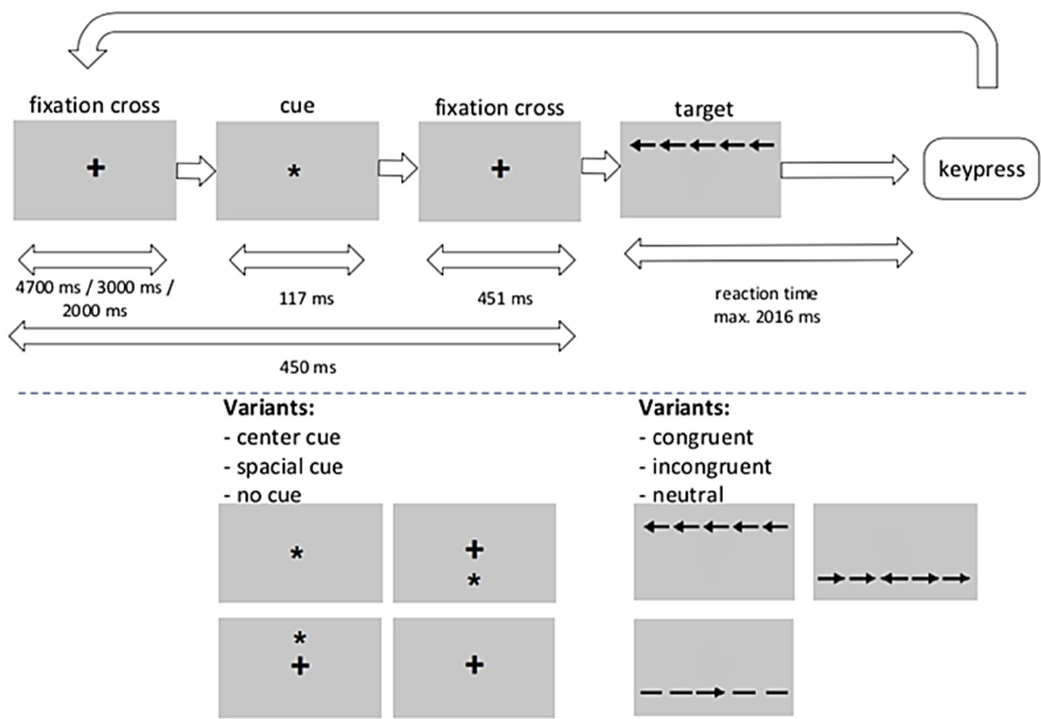
Figure 3. Modified ANT based on the version originally developed by Posner et al. [19]: upper panel, trial structure; lower panel, task variants. Symbols: + . . . fixation cross; * . . . spatial cue before target arrows and flankers appear; → , ← (middle) . . . displays the corresponding button for a correct answer; → , ← (other) flanking stimuli showing the same (congruent) or opposite (incongruent) side as the middle arrow, – . . . neutral flanking stimuli.